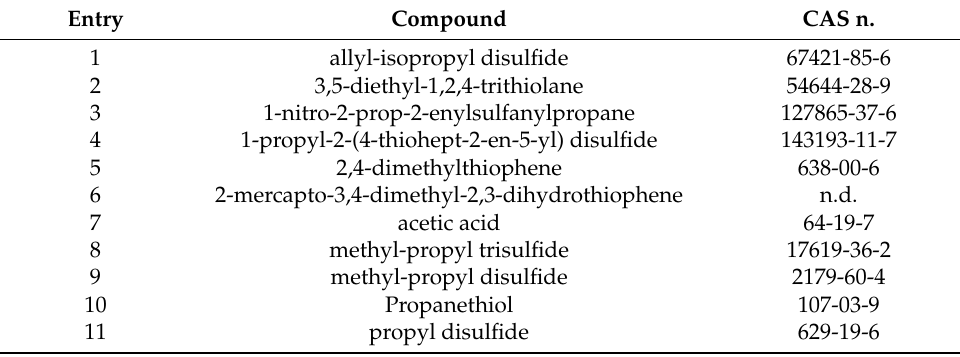
Table 2. VOCs identified and quantified in HS/SPME GC–MS analysis of onion